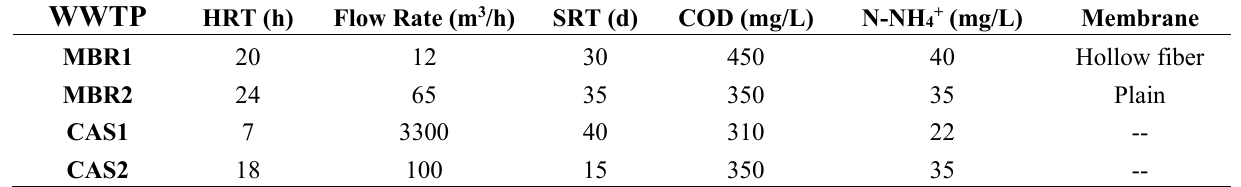
Table 1. Operational Parameters of the treatment plants where the sludges were collected. WWTP HRT (h) Flow Rate (m 3 /h) SRT (d) COD (mg/L) N-NH 4+ (mg/L)